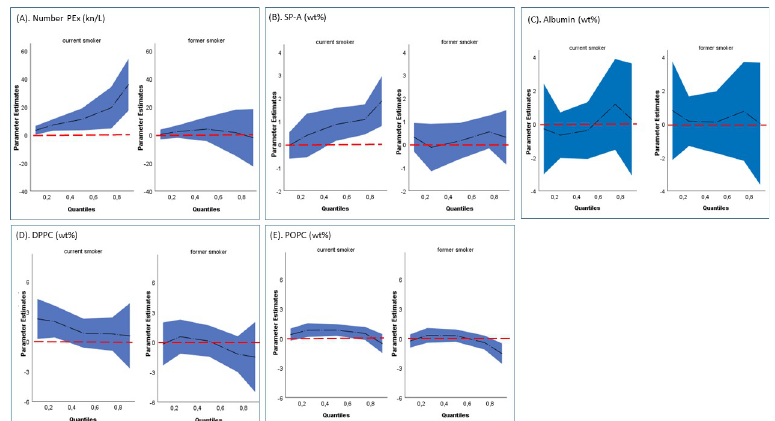
Fig 1. Levels of number PEx (kn/L), phospholipids and proteins in PEx (wt%) among current- and former smokers compared to never-smokers. Plots illustrating age- and sex-adjusted quantile regression estimates of current- and former smokers to never-smokers (the red dotted line). (A) number PEx (kn/L), (B) SP-A (wt%), (C) Albumin (wt%), (D) DPPC and (E) POPC (wt%) were analyzed separately. Quantiles on x-axis refers to the distribution of the PEx-variable studied. Estimates from quantile regression denoted by black dotted line with blue confidence intervals. https://doi.org/10.1371/journal.pone.0253825.g001 that of never-smokers, in multiple regression analysis adjusted for age and sex (Fig 2A, upper graph). However, when restricting the analysis to subjects with abnormal lung function (FEV1, FVC, and/or FEV1/FVC < LLN), current smokers had markedly higher number PEx than never- smokers (Fig 2A, lower graph). The magnitude of the effect was amplified with increasing number PEx, as illustrated by the different estimates in quantile 0.5 compared to quantile 0.75 (Coef 14.2 kn/L, CI: 4.4–24.0 and Coef 33.4 kn/L, CI: 15.9–50.9, respectively). Associations between smoking status and distribution of SP-A in these restricted analyses, showed similar patterns as in the entire study population, although only barely significantly increased in a small window of the higher quantiles of the SP-A distribution (Fig 2B). Current smokers with normal lung function had higher levels of DPPC than never-smokers along its entire distribution (Fig 2D, upper graph), and POPC levels, but with a large and not significant confidence interval in the upper quantiles (Fig 2E, upper graph). No significant associations were found regarding current smokers and either of the lipids, in the analysis restricted to sub- jects with abnormal lung function (Fig 2D and 2E, lower graphs). Albumin showed no effect of current smoking (Fig 2C). Table 3. Correlation coefficients (spearman) between each PEx parameter and characteristics in current smokers (n = 37).